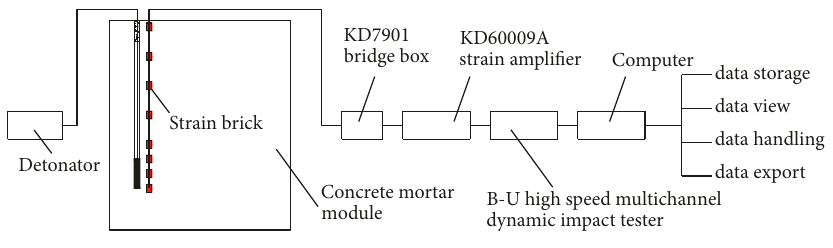
Figure 5: Pressure test system.